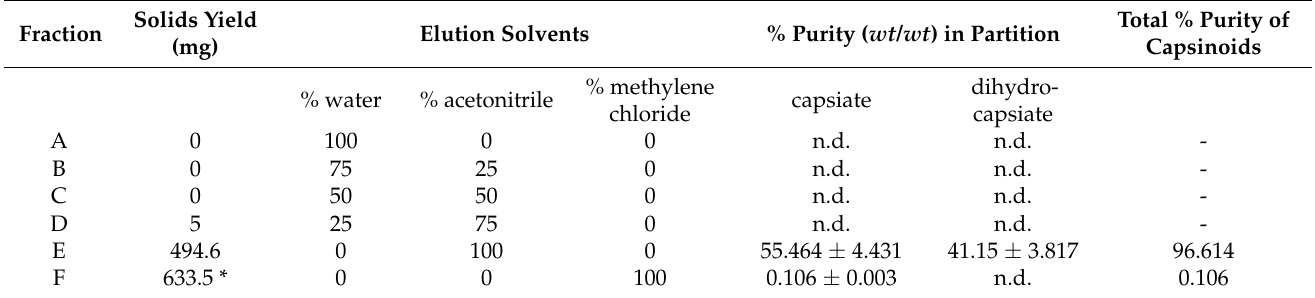
Table 3. Capsinoid percent purity in fractions generated from the bulk Diaion HP20ss column chromatography of the acetonitrile portion from the liquid/liquid extraction